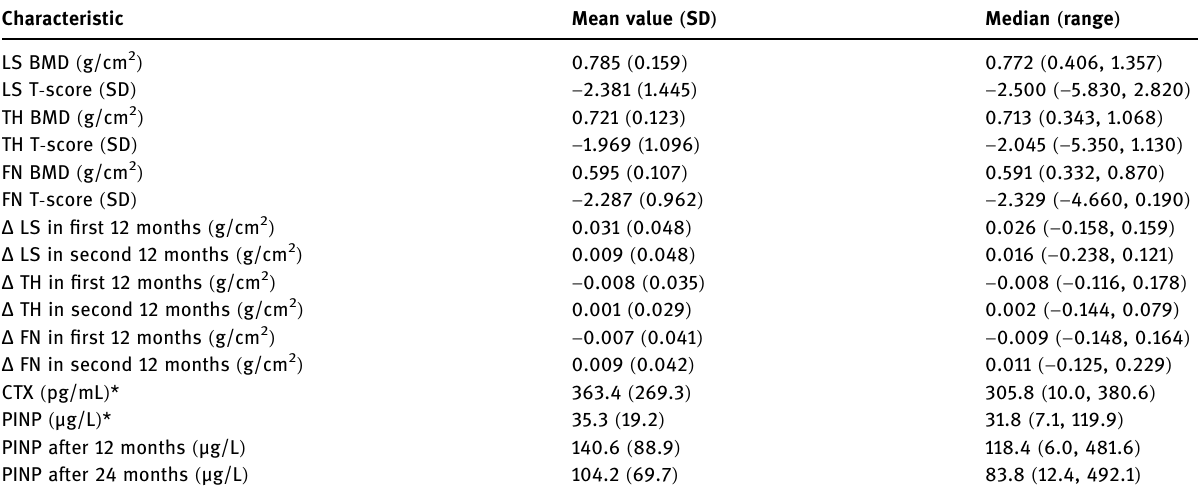
Table 2: Patients ’ BMD and bone turnover markers at baseline with the changes after 12 or 24 months of treatment; variables are described as mean value ( SD ) and median ( range